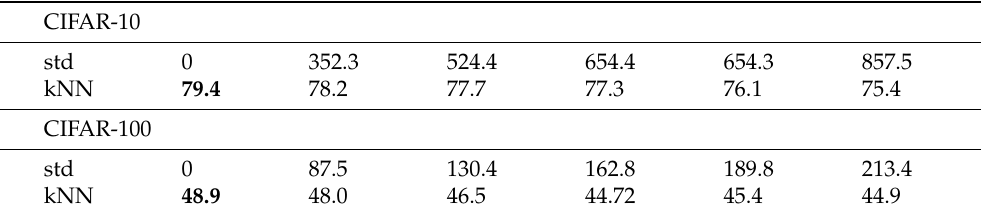
Table 4. CIFAR-10/100: evaluations for unevenly distributed pseudo-labels. The best results are highlighted by the bold.